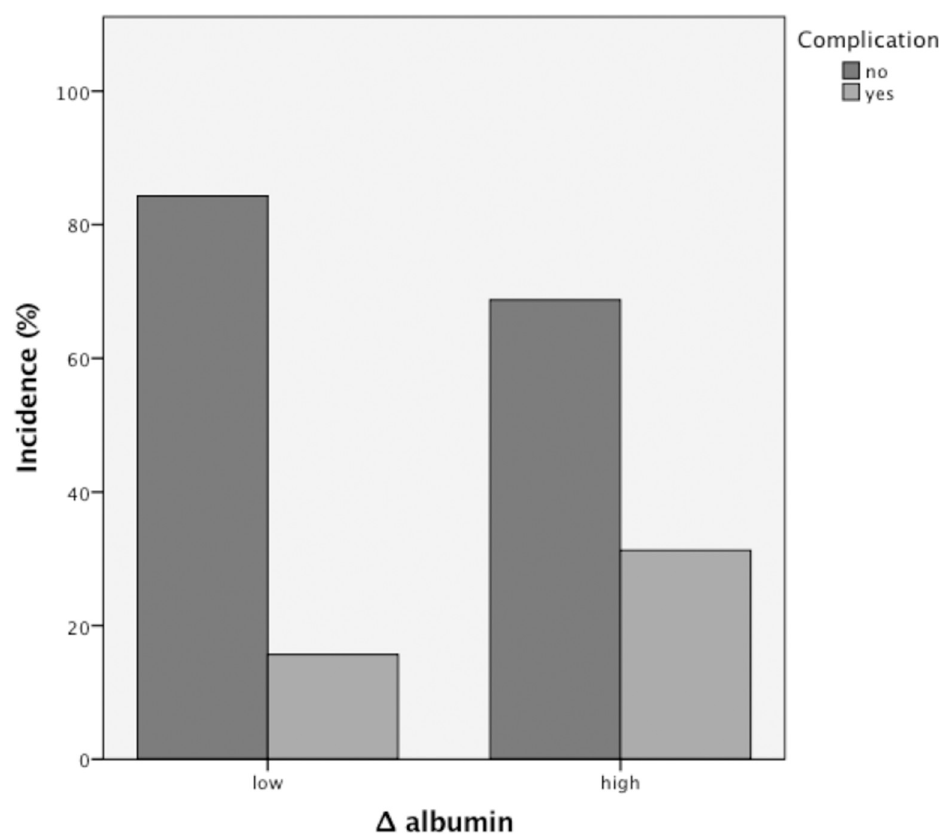
Fig 1. Perioperative albumin decline and the incidence of complications. Patients with a high perioperative albumin decline of more than 24.27% are at greater risk to developed postoperative complications (31.3% vs.